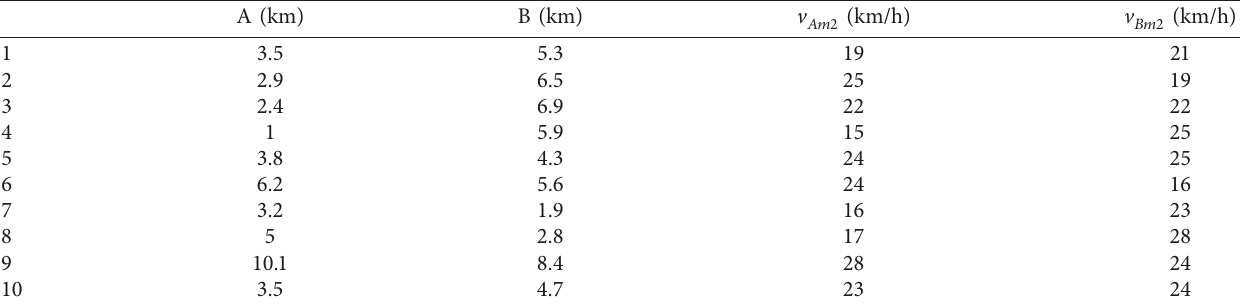
Table 5: Speed-distance matrix from demand point to demand point.